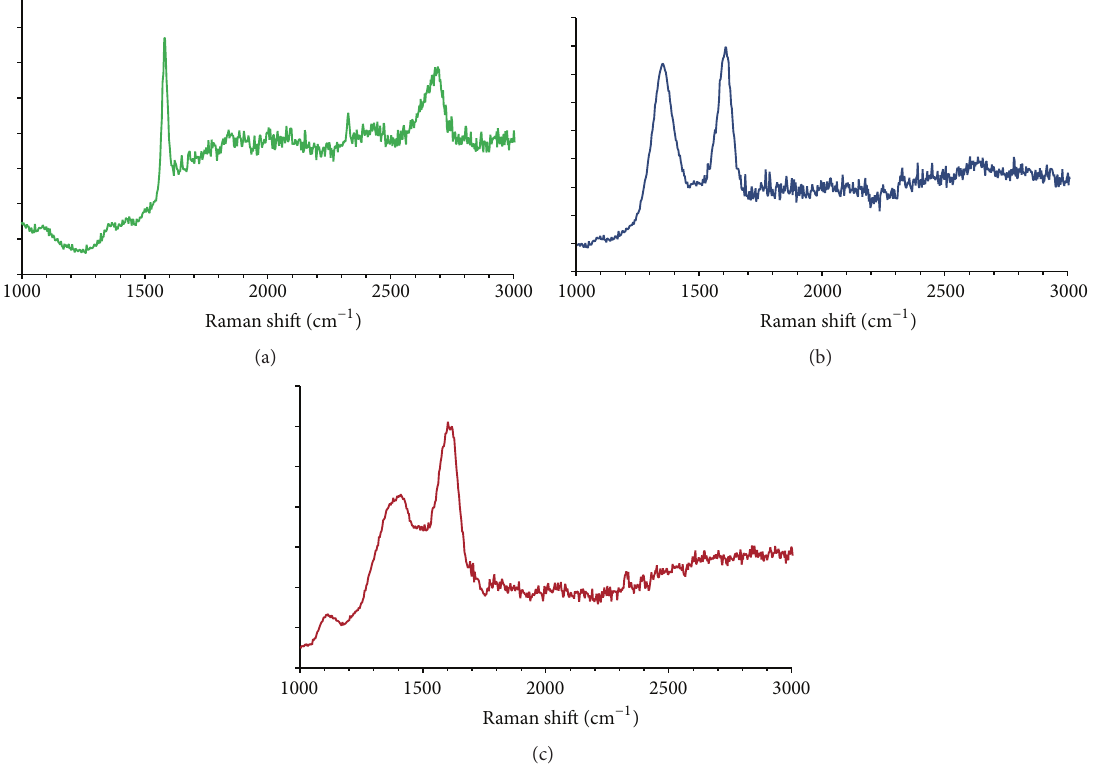
Figure 3: Raman spectra for graphite (a), commercial activated carbon (b), and amorphous carbon prepared in this work (c). The samples were excited by a 532 nm laser light with 30 mW